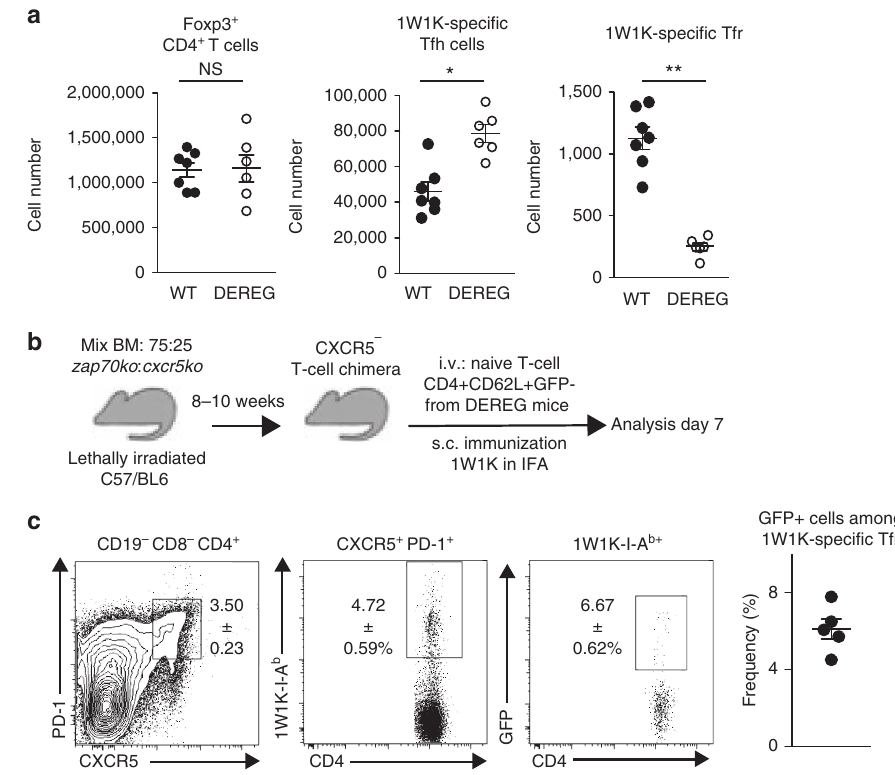
Figure 4 | Naive CD4 þ T cells can become Tfr cells. DEREG and WT mice were immunized with 1W1K emulsified in IFA and were treated with DTx on days 0 and þ 1. ( a ) Absolute numbers of total Foxp3 þ CD4 þ Tcells, 1W1K-specific Tfh cells and 1W1K-specific Tfr cells in dLN 7 days after immunization in WT (white circles) and DEREG mice (black circles). Data are representative of six mice per strain. Data were analysed using the non-parametric Mann– Whitney test * P o 0.05, ** P o 0.01, mean ± s.e.m. ( b ) Experimental outline. ( c ) Flow cytometric dot plots showing follicular T cells (CXCR5 þ PD-1 þ ), 1W1K-specific follicular cells (1W1K-IA b þ ) and 1W1K-specific Tfr cells (GFP þ ) in the dLN 7 days post immunization with 1W1K in IFA. Data shown are from one experiment with five mice and are representative of two independent